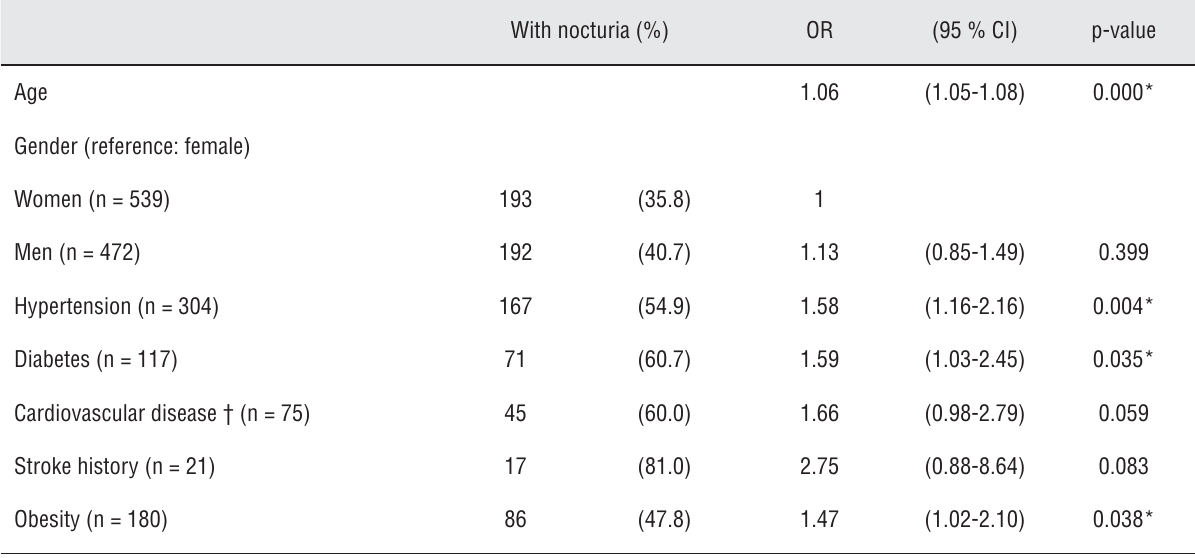
Table 3 - Prevalence of nocturia (  2 episodes/night) in potential factors and the analysis for the risk factors of